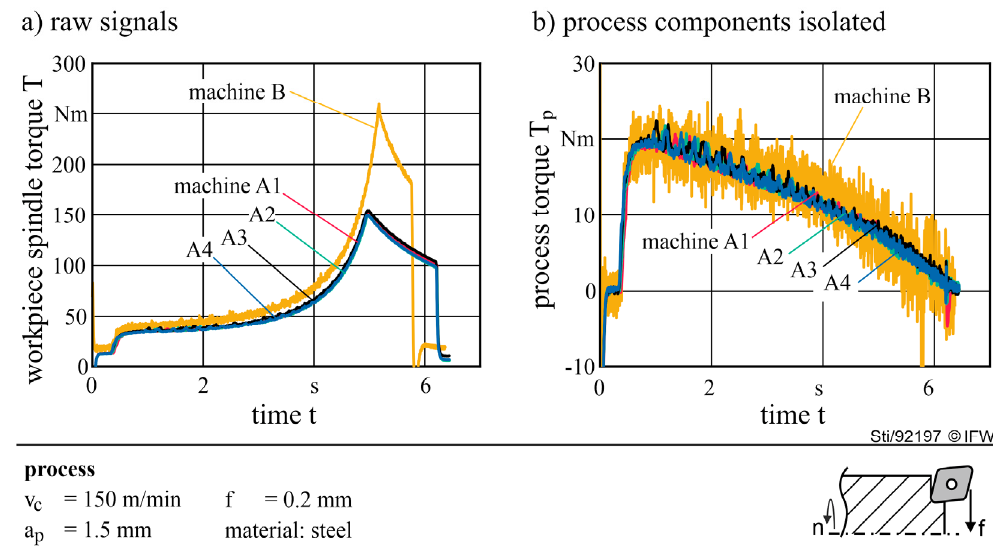
Figure 3. Comparison of ( a ) raw signals as recorded from the machines and ( b ) process components isolated from raw signals. The depicted interval constitutes a single segment with a face turning operation in OK-condition.